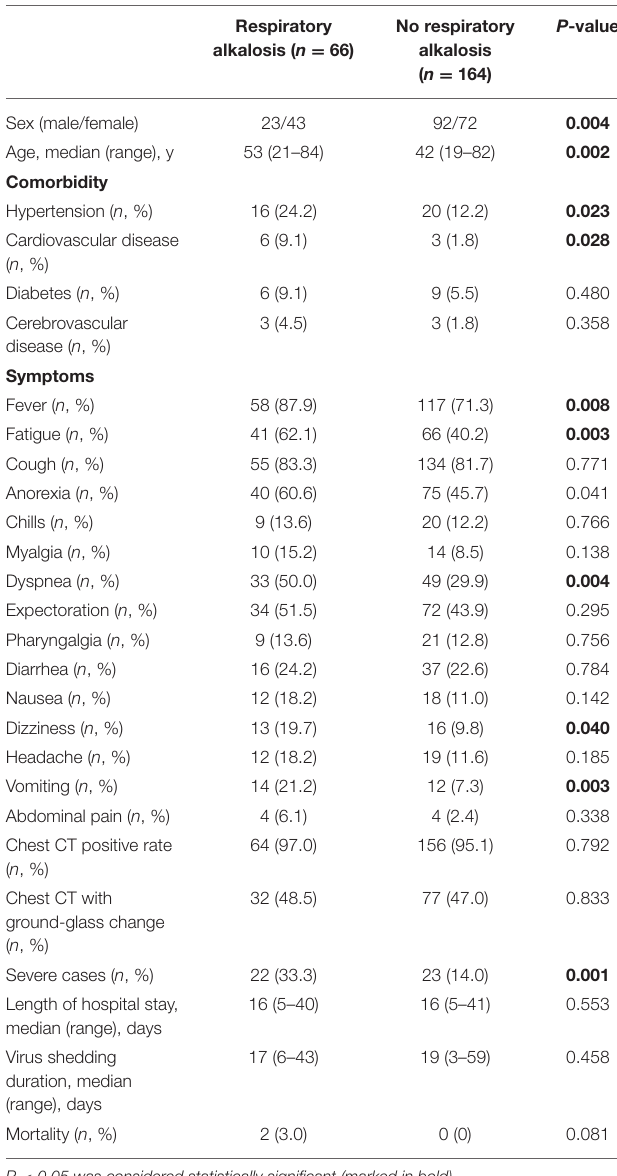
TABLE 1 | Baseline characteristics of COVID-19 patients with or without respiratory